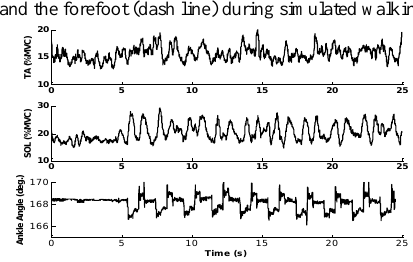
FIGURE 1: Mechanical force applied on the heel (solid line) and the forefoot (dash line) during simulated walking